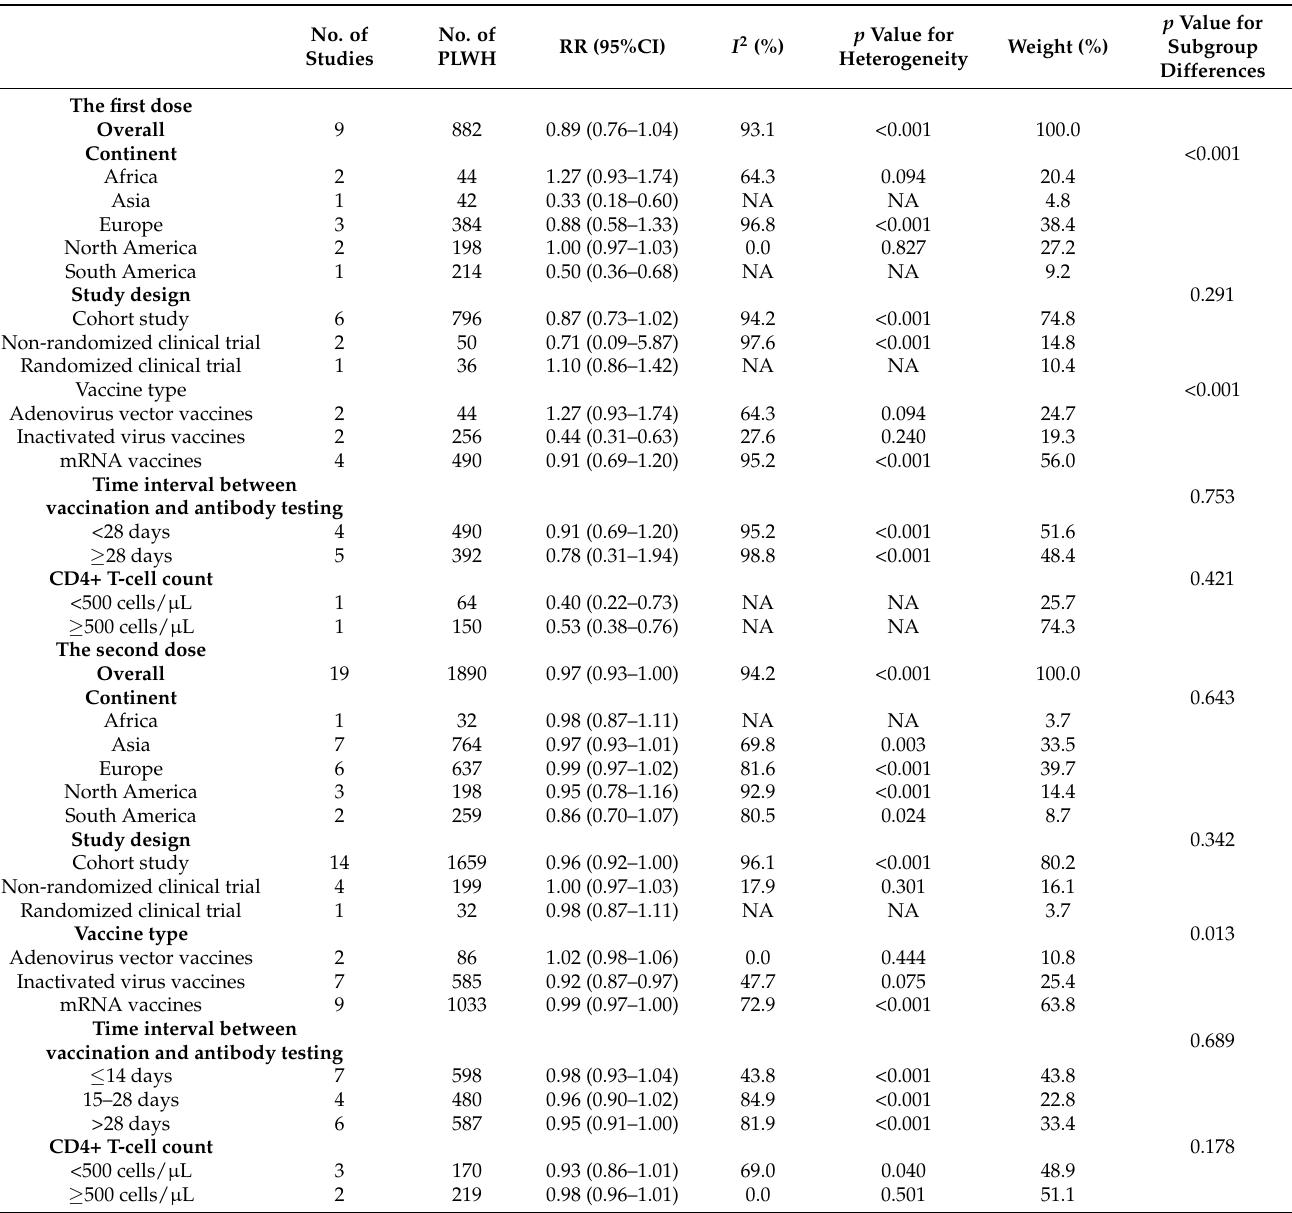
Table 2. Risk ratios for seroconversion among full-vaccinated people living with HIV compared with healthy controls by